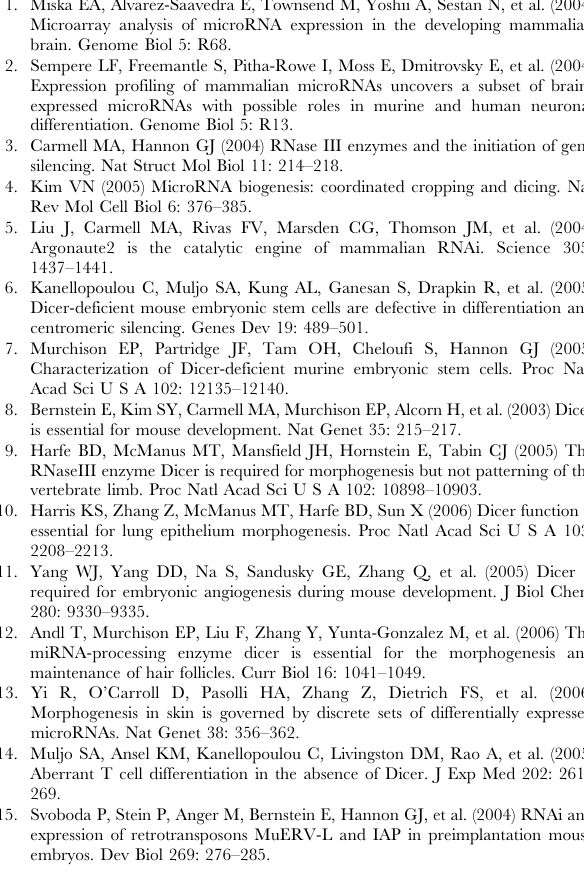
males. Immunofluorescence analysis shows Mvh (green) and nuclei (blue). Figure S7 Dispensable role of Ago2 in spermatogenesis. (A) Immunofluorescence analysis for Mvh (green) and nuclei (blue) in 4 weeks-old Ago2CKO testis. Middle image show high magnifi- cation of white broken rectangles in left image. Note that right image shows spotty staining of Mvh in spermatids. Scale bar: 50 m m (B) Genotypes of progeny and schematic ratio of genotype of spermatogonia and spermatozoa. The pie chart summerises percentages of genotypes of progeny from Ago2CKO males crossed with wild-type females. The number of progeny tested is shown in the center of the circle. Note that intact floxed ago2 allele (F) is inherited by only 7% of progeny from Ago2CKO males, similar to that from DicerF/ + TNAP-Cre males (Figure 4). Illustration in the right side of the pie chart estimates schematic ratio of Ago2 excision in spermatogonia and spermatozoa, based on the percentages in the pie chart. Since floxed ago2 allele is inherited by only 7% of progeny from Ago2CKO males, Ago2- deleted spermatogonia seems to develop normally into fertile spermatozoa. Found at: doi:10.1371/journal.pone.0001738.s007 (0.95 MB